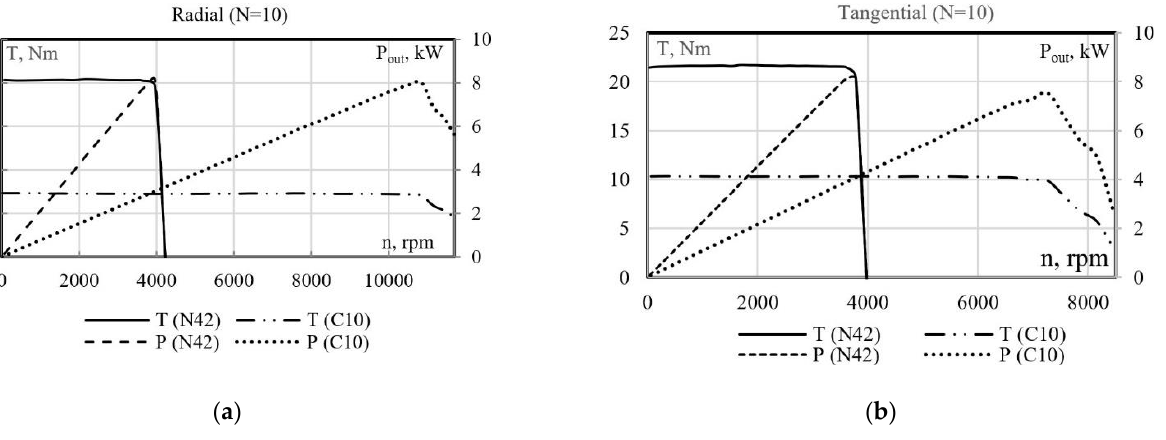
Figure 5. Electromechanical characteristics of the tangential and radial machines with N42 and C10 PMs for N = 10 turns. Here, the X -axis defines the speed of the machines and the Y -axis shows the torque and output power.